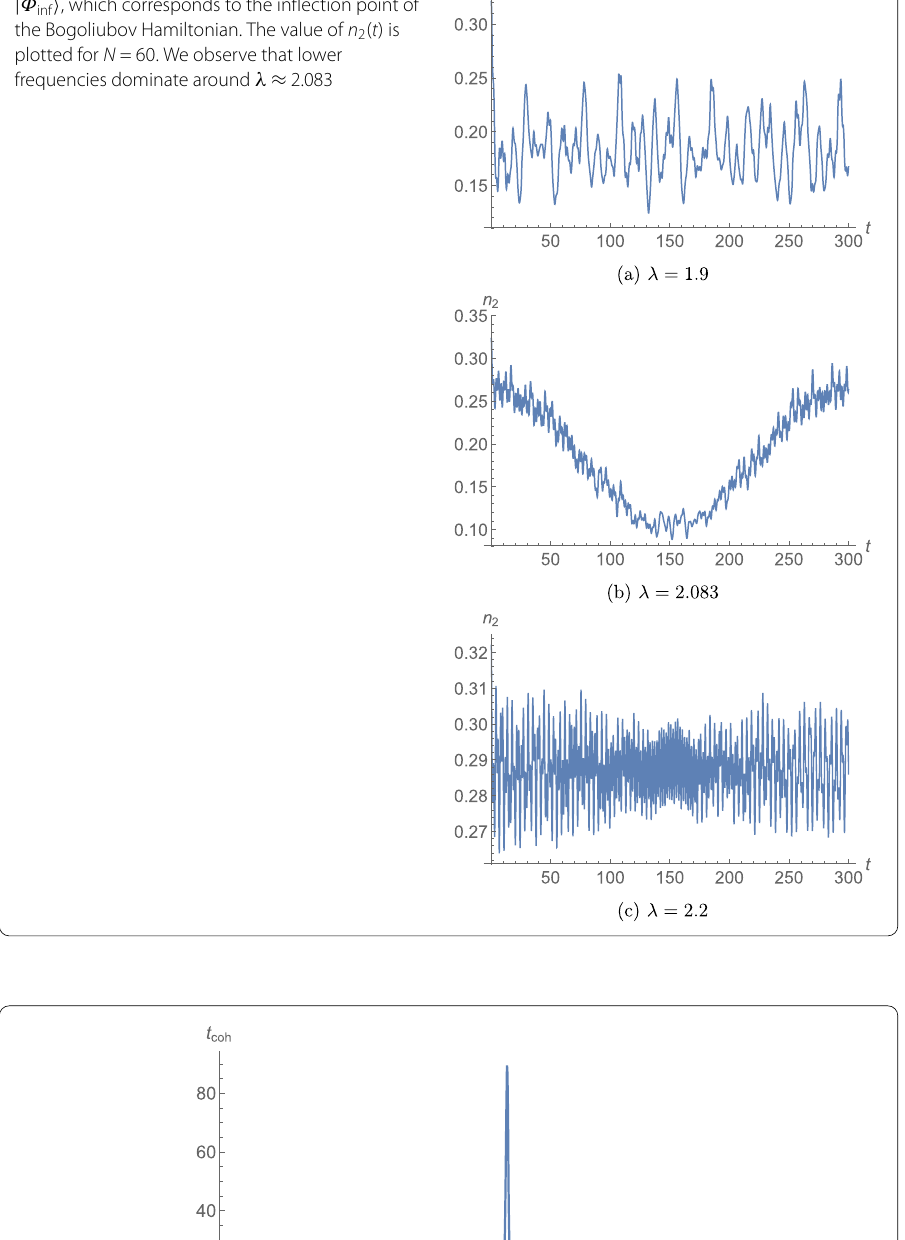
Figure 6 Time evolution of the quantum state (cid:2) , which corresponds to the inflection point of | Φ inf the Bogoliubov Hamiltonian. The value of n 2 ( t ) is plotted for N = 60. We observe that lower frequencies dominate around λ ≈ 2.083